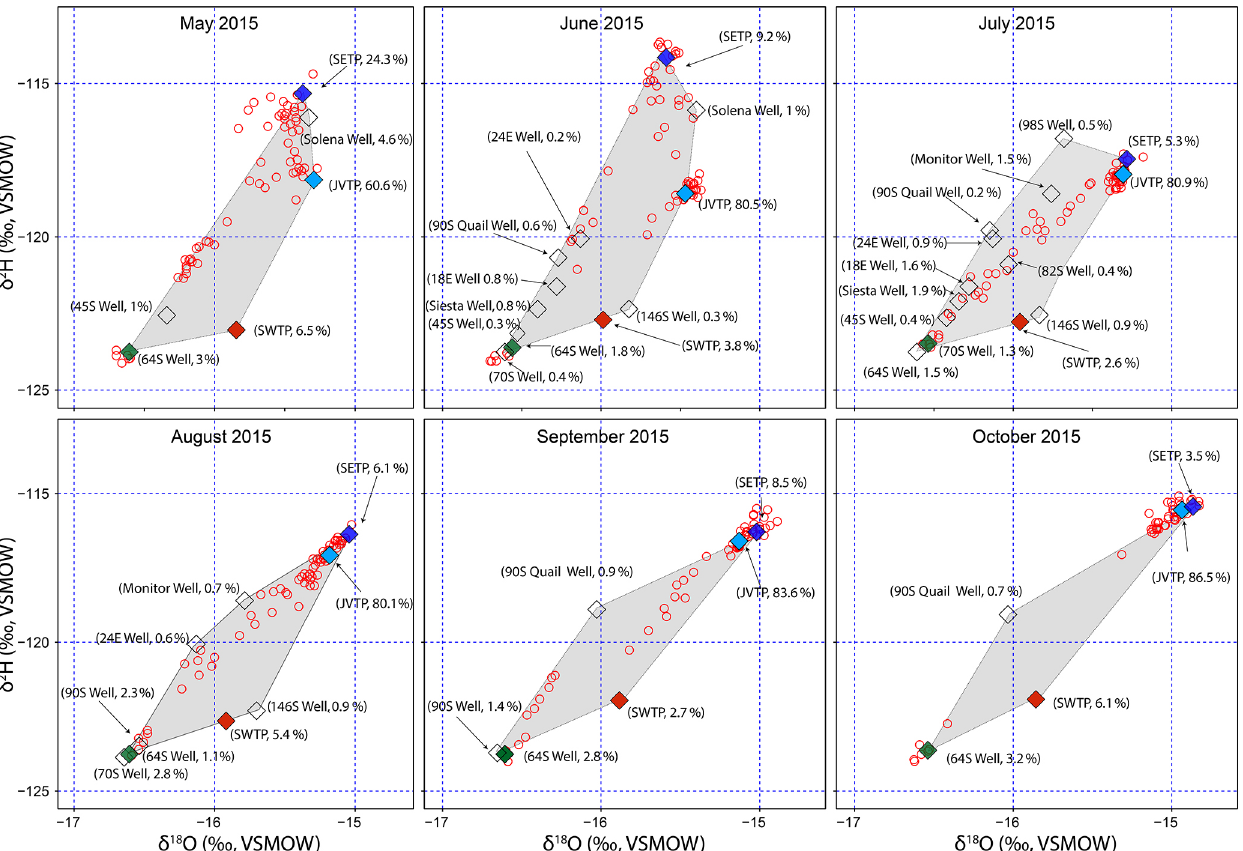
Figure 4. Sources and distribution site isotope ratios from May to October 2015. Red hollow circles and diamonds represent distribution sites and sources, respectively. The four major sources (JVTP, SETP, SWTP, and 64S Well) have been colored light blue, dark blue, orange, and green, respectively. The grey region is the convex hull of the sources (defined as the minimum area enclosing all the source isotope values). The percentage value besides the name of the source represents the total volume of water supplied by the source in the given